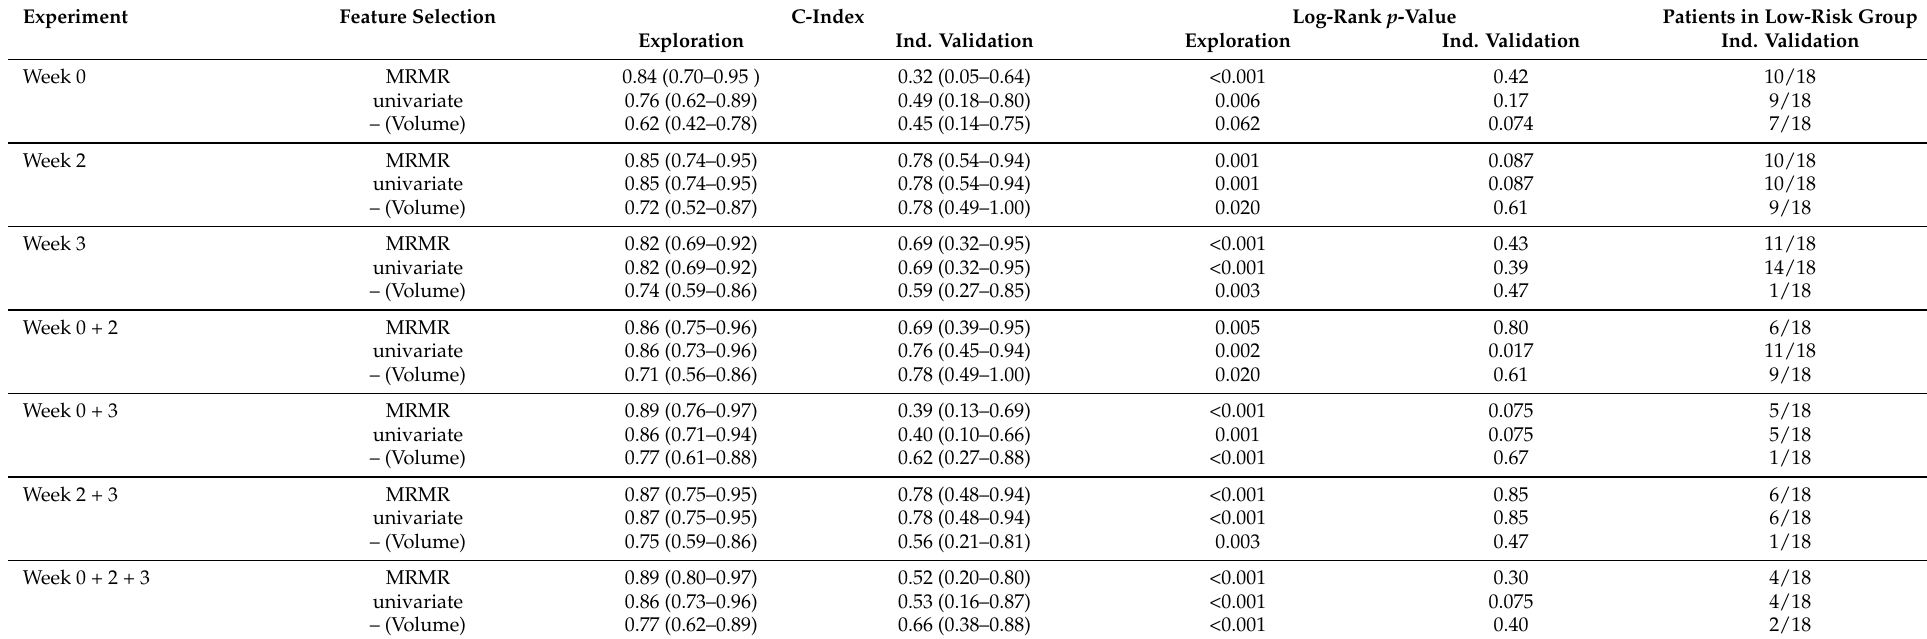
Table 3. Final signature model performance (CT): Values in parenthesis denote 95% confidence intervals based on bootstrapping. Values in bold denote the best performance (C-index) and statistically significant stratification (Log-rank p -value) for the independent validation cohort. For each experiment, the last row shows the performance of a baseline model that used tumor volume as a feature. The last column provides the fraction of patients assigned to the low-risk group based on the prediction cutoff. The number of patients in the low-risk group of the exploratory cohort is always 18 out of 37, as the median prediction was used as the